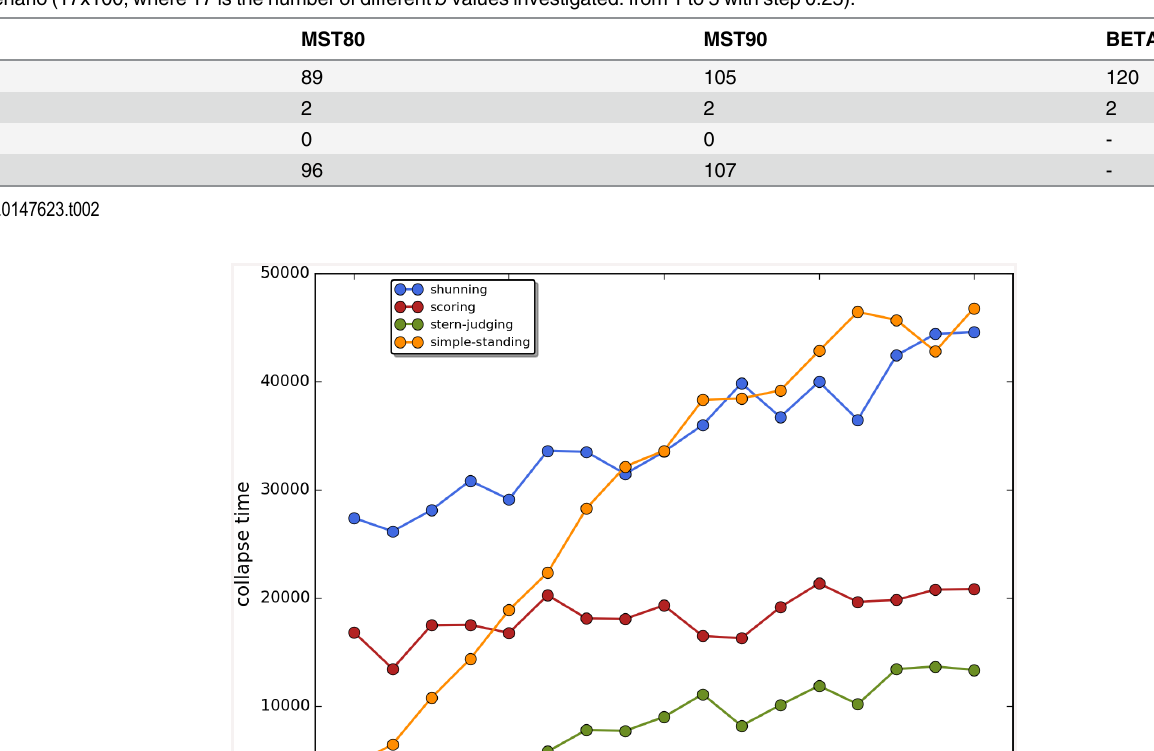
Table 2. The number of runs where cooperation survived in the three main scenarios. The table shows the number of runs where cooperation survived after 10 4 steps above the 0.05 threshold in the three main scenarios as a function of the investigated social norms, out of 1700 runs that were made for each